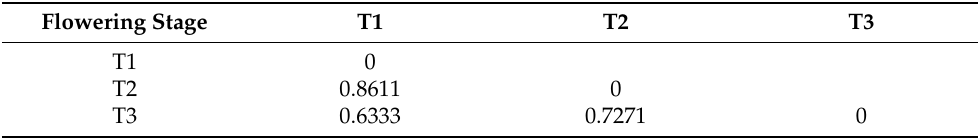
Table 3. Bray–Curtis dissimilarity index among different flowering stages of L. caudata . Table 3. Bray − –Curtis dissimilarity index among different flowering stages of L. caudata. Flowering